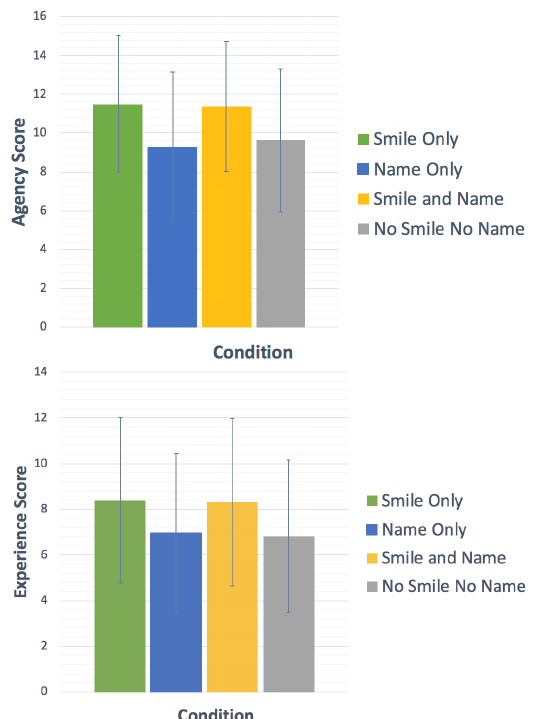
Figure 6: Effects of smiling and use of name on perceptions of robot agency and experience. Note: error bars represent 1 Standard Devi- ation of